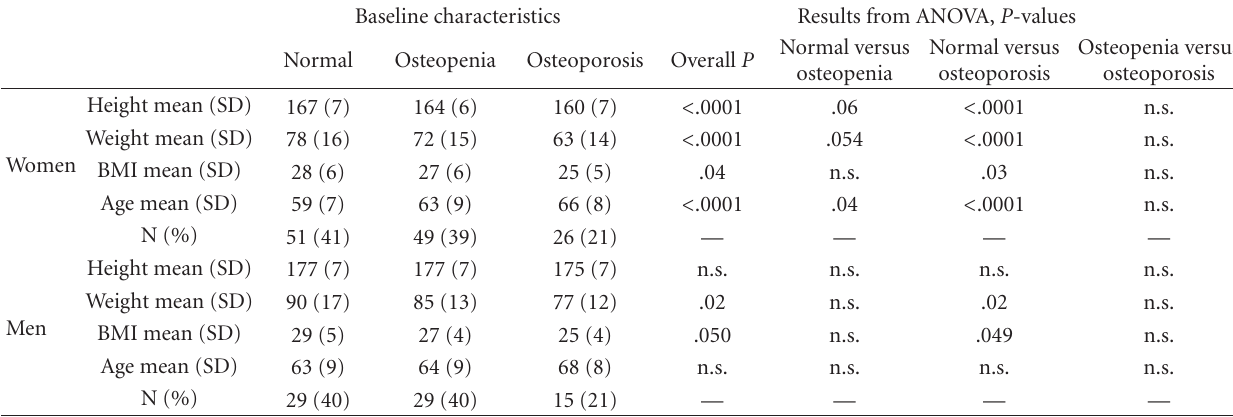
Table 1: Demographic data on fallers included from emergency department, n = 199, according to osteoporotic status. Results from ANOVA with Bonferroni correction for comparison between